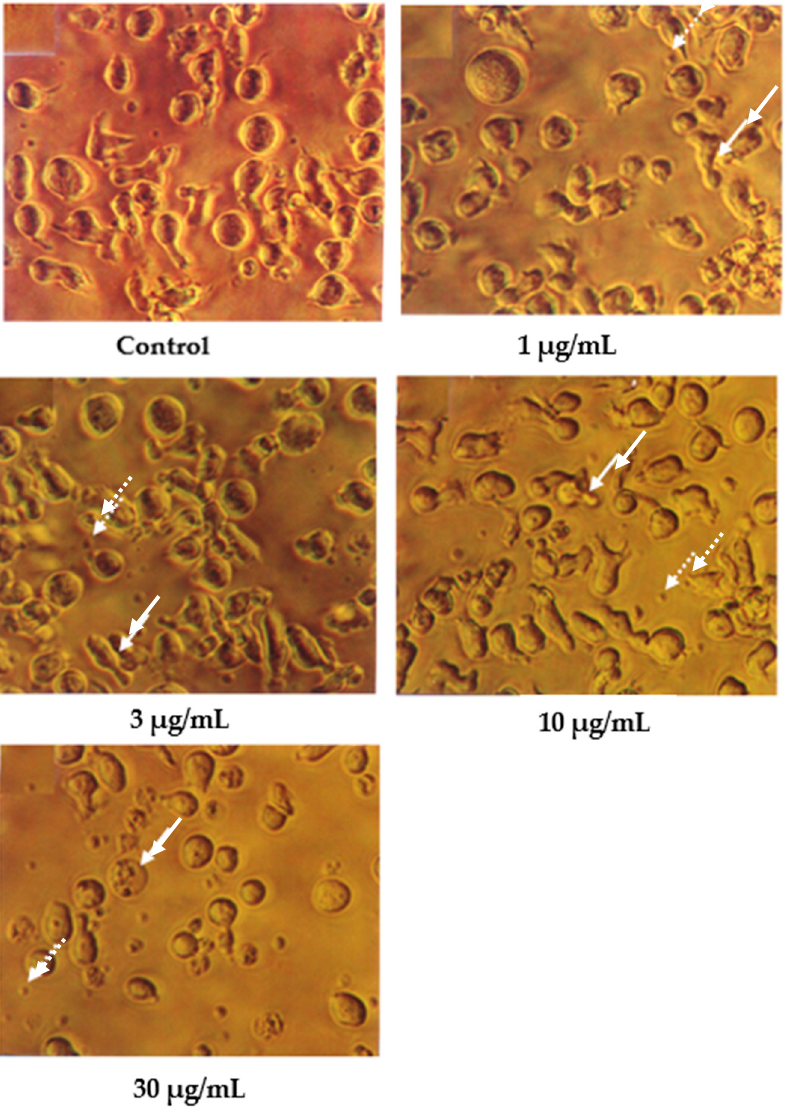
Figure 3. CEM-SS cells without treatment (control) or treated with different concentrations of damnacanthal for 24 h (200 × magnification). Complete arrows indicate apoptotic cells, and dotted arrows indicate necrotic cells.